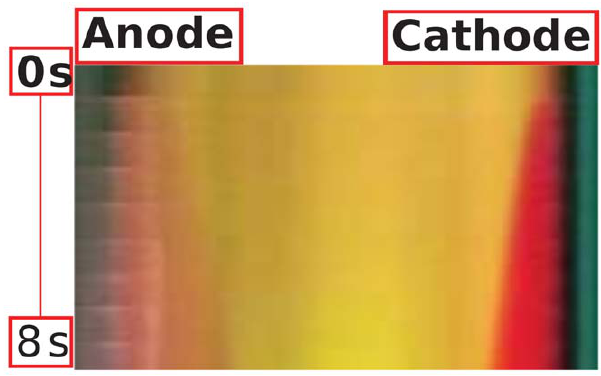
Figure 2. Evolution of the anodic acid (pink) and cathodic basic (red) pH fronts. Space-time measurement of pH variation in an in vitro gel under ECT (8 pulses, 400 V, 300 m s, 1 Hz).